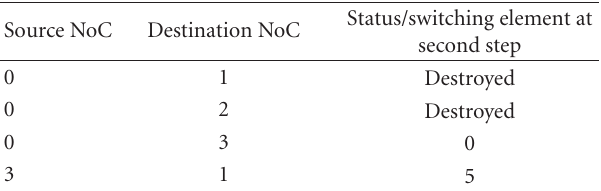
Table 20: Intermediate SE information while data is moves from source NoC to destination NoC (in between some information destroyed before reaching to the destination successfully) at second step of worst case.